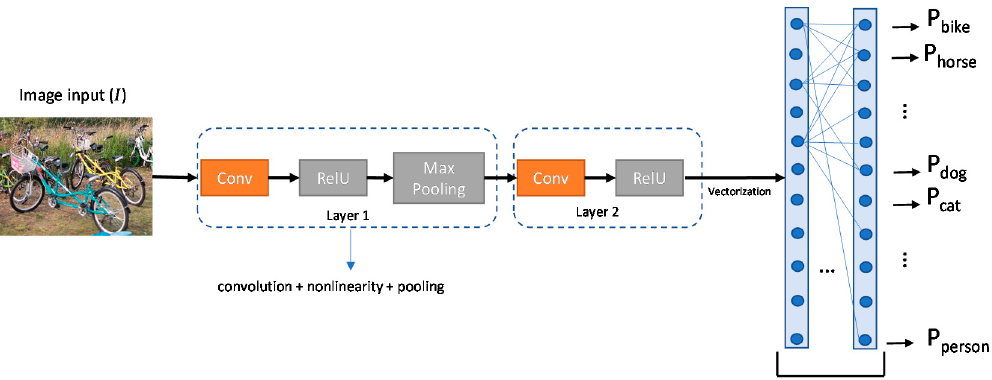
Figure 1. Convolutional neural network (CNN) architecture.